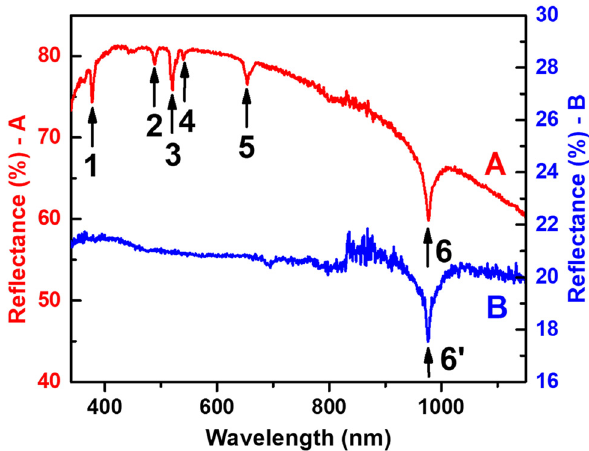
Figure 4: Di ff use re fl ectance spectra of the powder samples of down - conversion RE phosphors. Curve A corresponds to